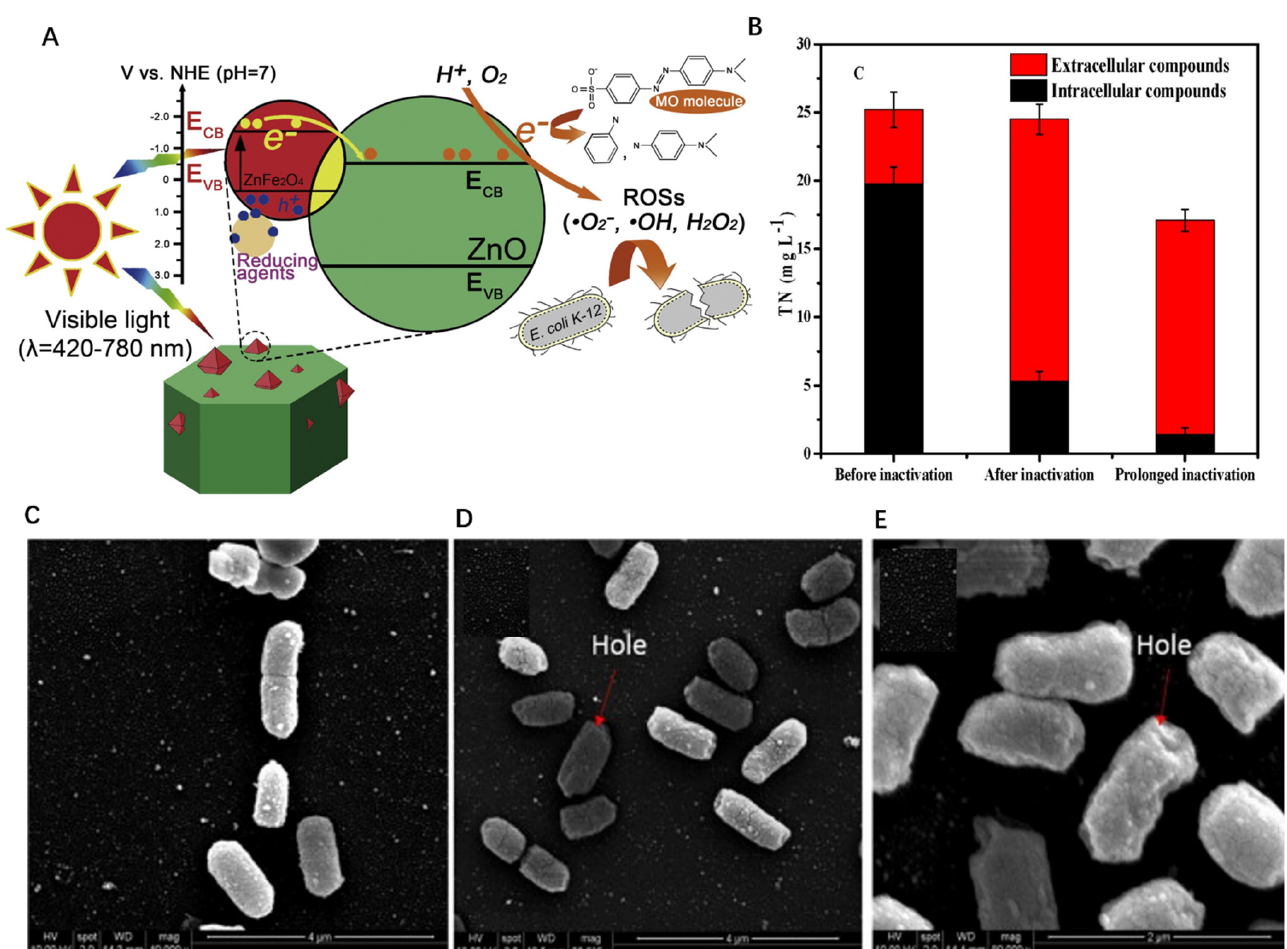
Figure 2. ( A ) Schematic illustration of photocatalytic sterilization mechanism of fabricated ZnO/ZnFe 2 O 4. , copyright 2017 Elsevier B.V. ( B ) Changes in total organic carbon before and after long-term inactivation of Escherichia coli , copyright 2018 Elsevier B.V. ( C – E ) SEM images of E. coli K-12 with photocatalytic inactivation treatment, copyright 2015 Elsevier